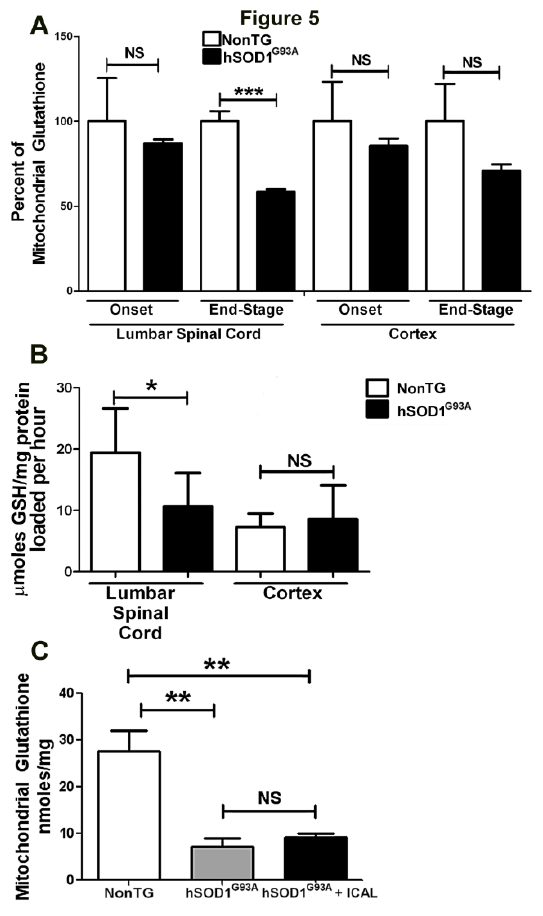
Figure 5. Spinal cord mitochondrial GSH levels and mitochondrial GSH transport are significantly diminished in hSOD1 G93A mice. ( A ) Mitochondria were isolated from NonTG and hSOD1 G93A mice at onset (~90 days old) and end-stage (~120 days old) from lumbar spinal cord and whole cortex, and total GSH was measured. All measurements were normalized to protein and represented as a percent of NonTG. *** indicates p < 0.001; NS indicates no significant difference, as determined by an unpaired Student’s t -test, n = 4. Error bars indicate SEM. ( B ) Mitochondria were isolated from lumbar spinal cord and cortex of end-stage (~120 days old) hSOD1 G93A and age-matched NonTG mice, as described in ( A ). Isolated mitochondria were incubated with 2 mM GSH at 37 °C, 300 rpm for 4 h, after which mitochondria were washed 3× and total GSH was measured. All measurements were normalized to protein and represented as μmoles GSH/mg of mitochondrial protein loaded per hour. * indicates p < 0.05; NS indicates no significant difference, as determined by a paired Student’s t -test, n = 7. Error bars indicated SEM. ( C ) Mitochondria were isolated from lumbar spinal cord as described in ( A ) from untreated end-stage (~120 days old) hSOD1 G93A mice, hSOD1 G93A mice treated with Immunocal ® (hSOD1 G93A + ICAL) and age-matched NonTG mice. Total GSH was measured. All measurements of total GSH are normalized to protein and represented as nmols/mg of protein. ** indicates p < 0.01; NS indicates no significant difference, as determined using a one-way ANOVA with a post hoc Tukey’s test, n = 4. Error bars indicate